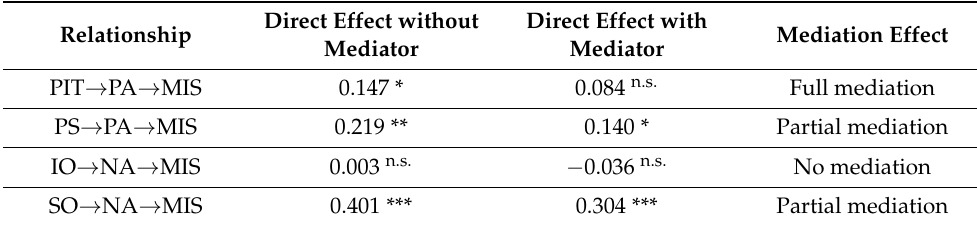
Table 4. Mediation